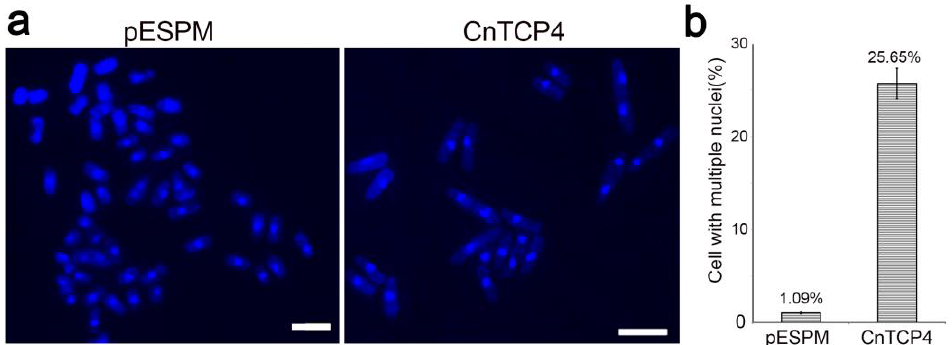
Figure 5. The e ff ect of expressing CnTCP4 on the appearance of fission yeast grown in a medium lacking VB1. ( a ) DAPI stained cells carrying an empty vector (pESPM) and those carrying the pESPM ::CnTCP4 transgene (CnTCP4). Bar: 10 µ m. ( b ) The frequency of cells carrying multiple nuclei. Values shown as mean ± SE ( n =